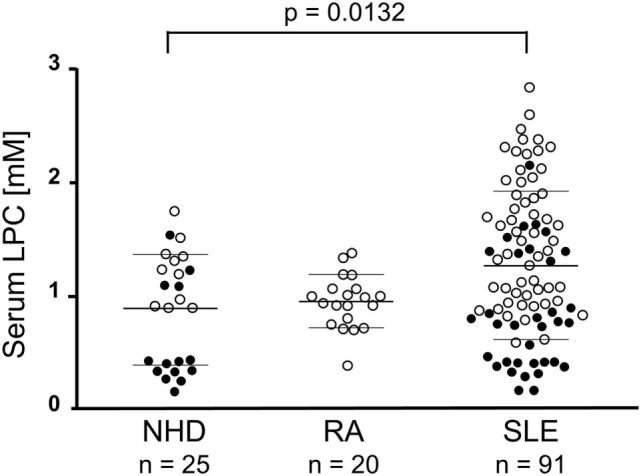
Lysophosphatidylcholine (LPC) serum levels of patients with systemic lupus erythematosus (SLE) are elevated. In serum samples of normal healthy donors (NHD), patients with rheumatoid arthritis (RA) and SLE LPC concentrations were analyzed by a multi-step coupled enzymatic test as depicted in Figure 1. LPC levels from individual serum samples, their means, and SDs are shown. Open symbols (only LPC values available), filled symbols (LPC values and phagocytosis index available), bold bars (cohort means), thin bars (cohort SDs).